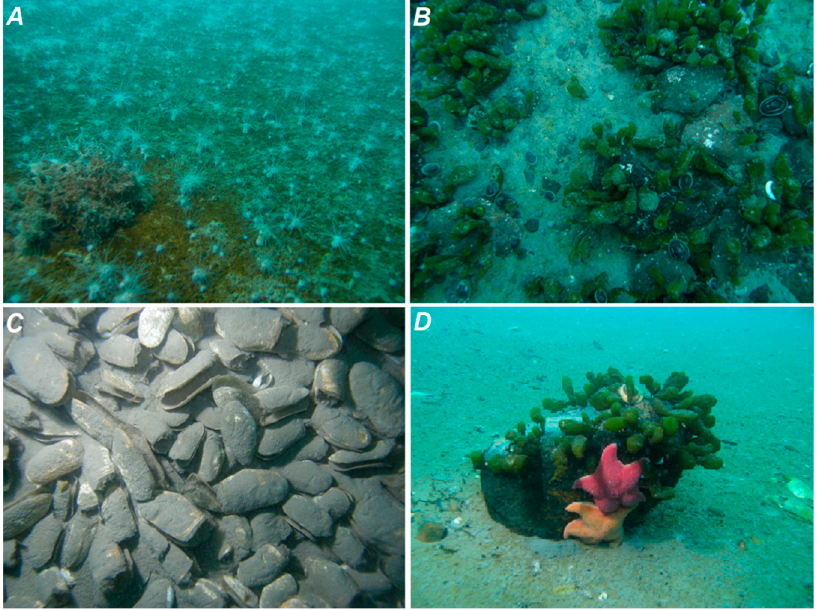
Figure 3. Benthic assemblages recognized in Herve Cove. ( A ) Soft bottom, ( B ) Hard bottom, ( C ) Soft bottom close to glacier stream, ( D ) Boulders (in text recognized as B1 ).